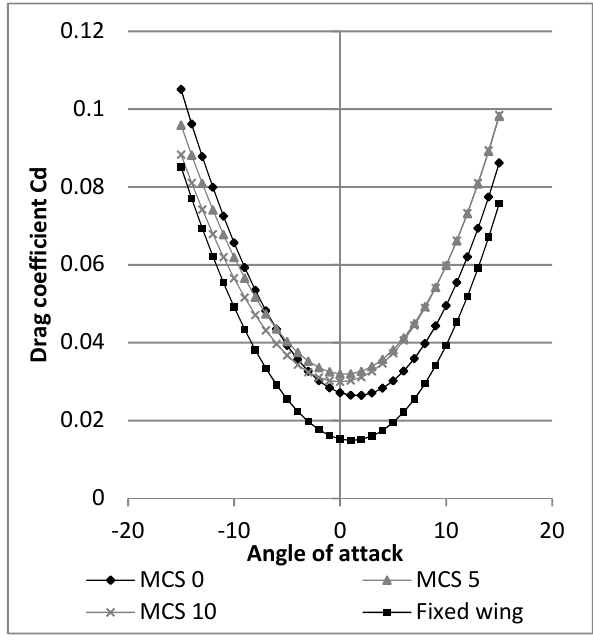
ffi cient variation with angle of attack for UAS-S4. Figure 27 . Drag coefficient variation with angle of attack for UAS-S4. Figure 27. Drag coe